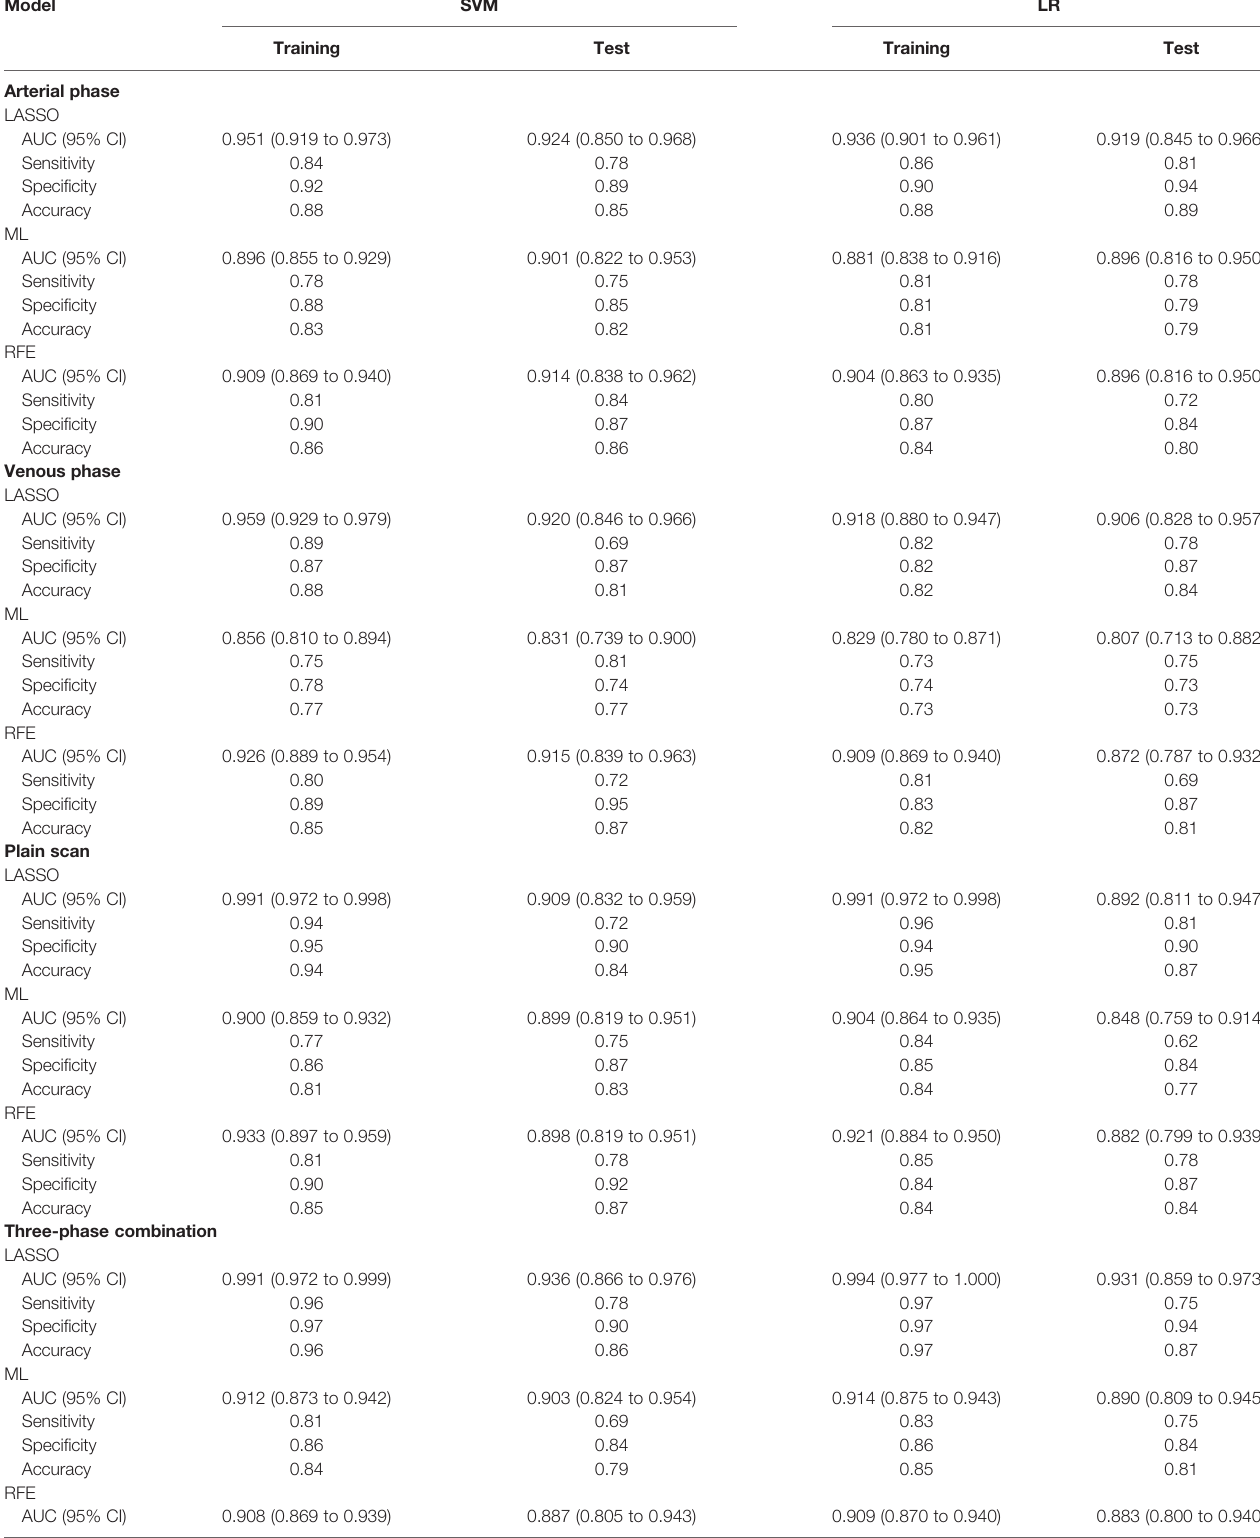
TABLE 3 | Diagnostic performance of the radiomics models.